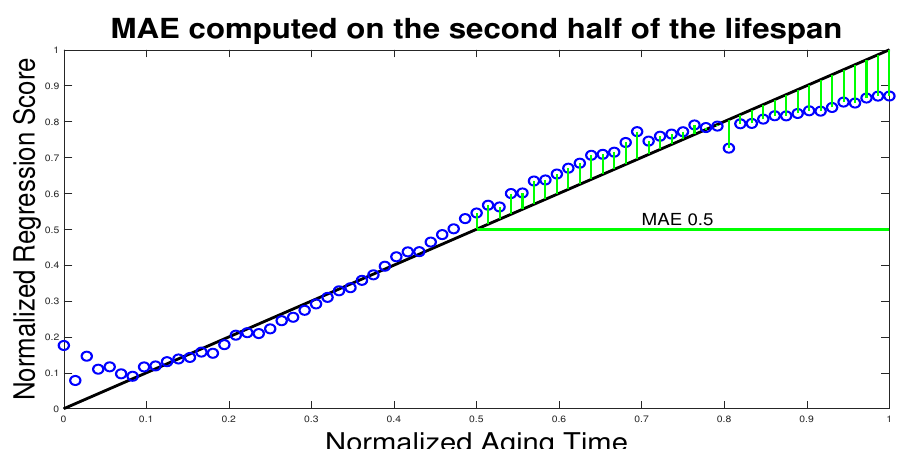
Figure 6. MAE computed over the second half of the specimen lifetime.